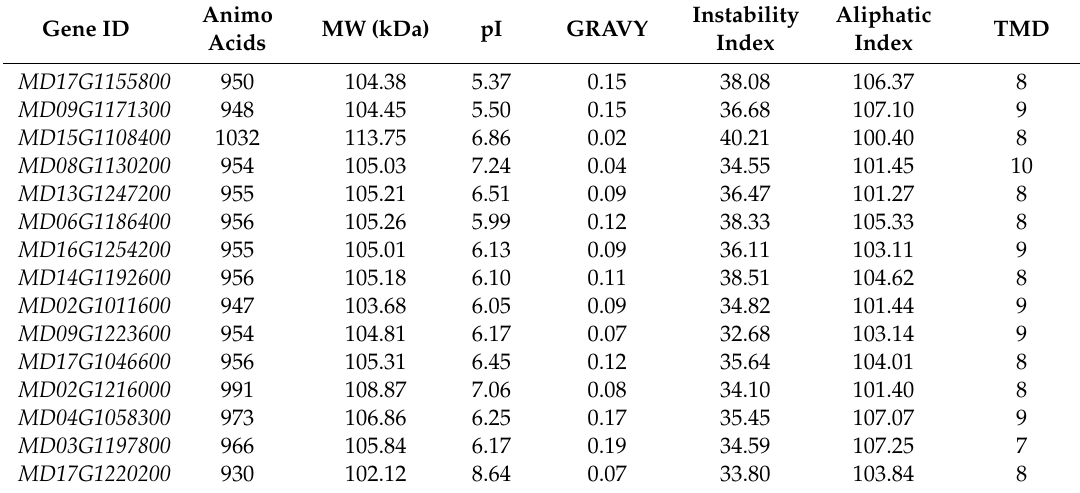
Table 1. Detailed information of physiological and biochemical characteristics of the apple P 3A -Type ATPases